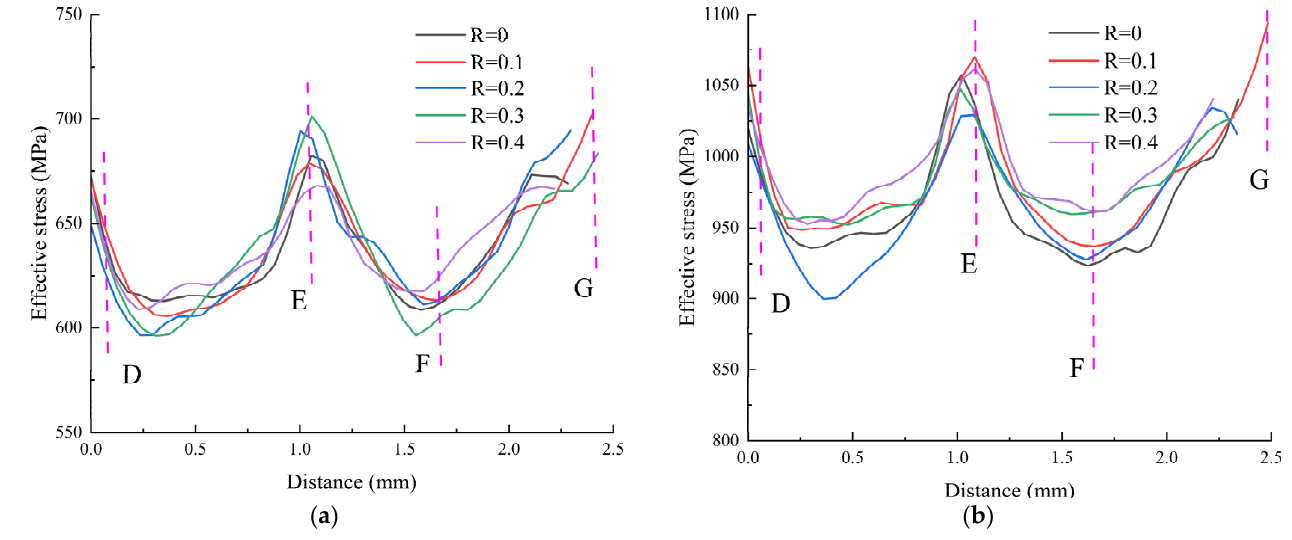
Figure 23. Variation curves of effective stress of the fins along DEFG trajectory direction under different conditions: ( a ): RT-EM; ( b ): CT-EM.